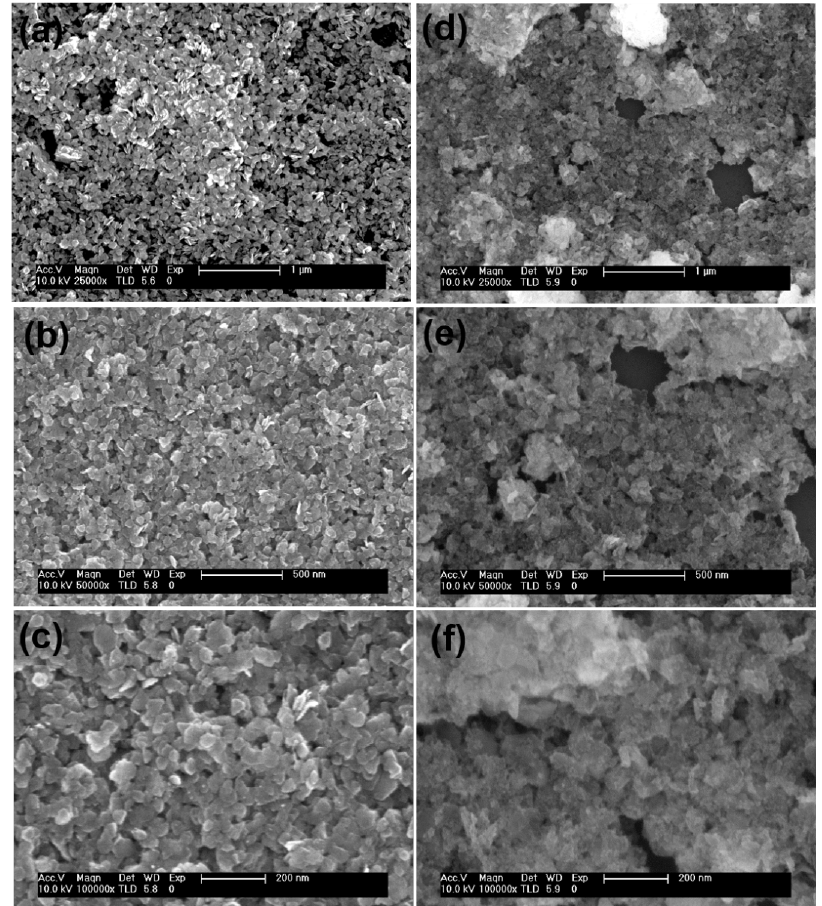
Figure 1. Morphological and structural characterization of SnS 2 and Sn 0.97 Zn 0.03 S 2 nanoflakes. ( a – c ) low magnification and high magnification scanning electron microscopy (SEM) image of SnS 2 ; ( d – f ) low magnification and high magnification SEM image of Sn 0.97 Zn 0.03 S 2 nanoflakes showing their hexagonal structure.